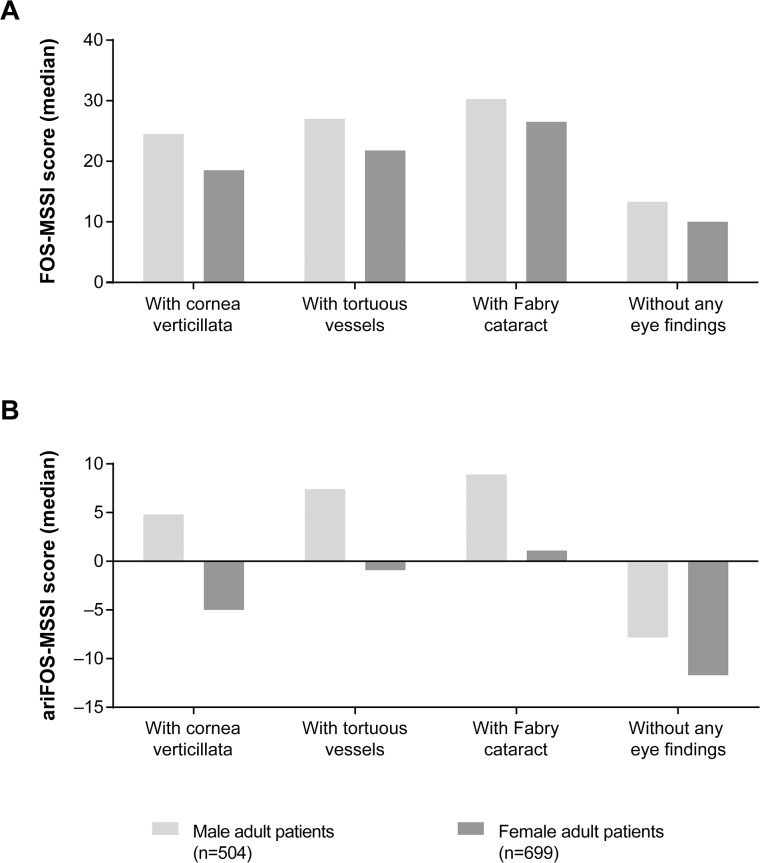
FOS-MSSI and ariFOS-MSSI score, and eye changes.Median (A) FOS-MSSI and (B) ariFOS-MSSI scores in male and female adult patients with and without eye findings. ariFOS-MSSI = age-related individual Fabry Outcome Survey Mainz severity score index; FOS-MSSI = Fabry Outcome Survey Mainz severity score index. The median FOS-MSSI and ariFOS-MSSI scores represent the medians after removing cornea verticillata from the calculation of the FOS-MSSI score.